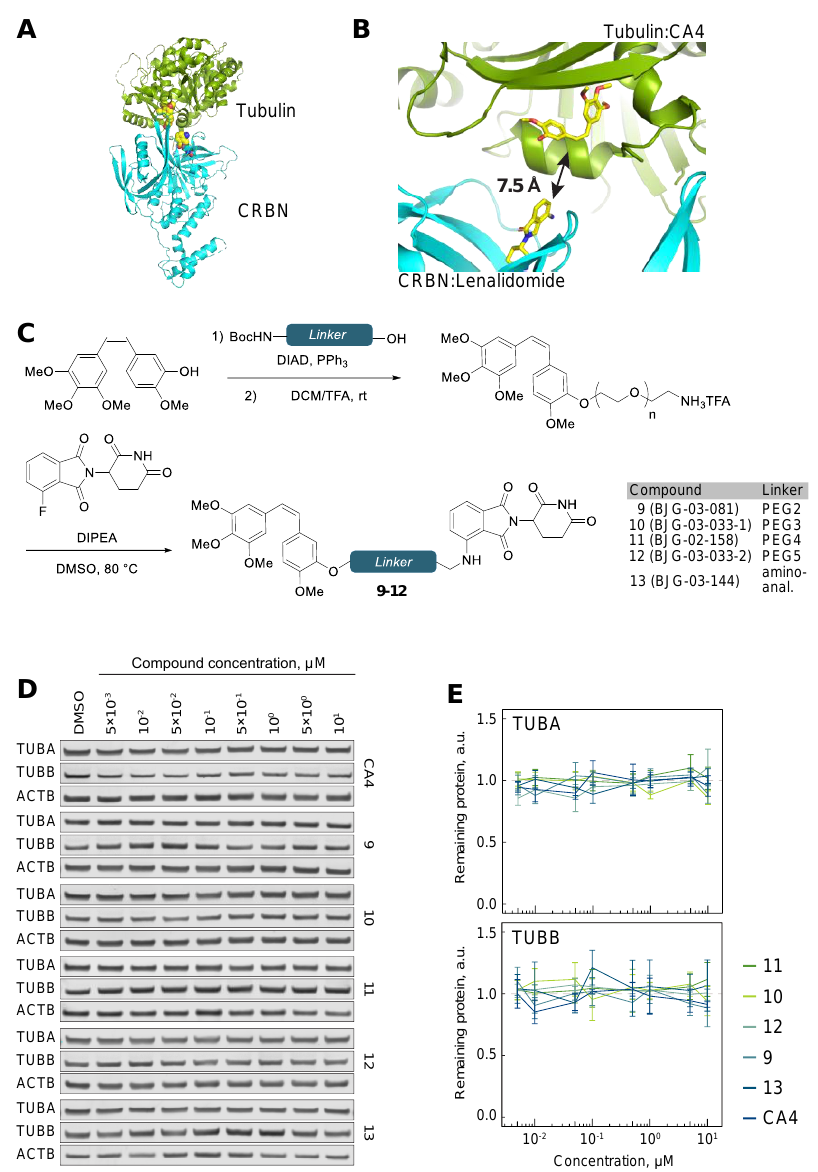
Figure 4. Tubulin evades CA4-CRBN targeted degradation. ( A ) The shortest linker docking pose of CRBN-bound lenalidomide (PDB ID 5fqd) and tubulin-bound CA4 (PDB ID 5lyj). ( B ) Corresponding shortest pairwise distance between lenalidomide and CA4 is permissive of a degrader approach. ( C ) Chemical synthesis of CA4-CRBN a degrader compounds with varying linkers. ( D ) TUBA and TUBB protein levels in hTert-RPE1 cells upon treatment with the indicated compounds. ( E ) Quantification of tubulin protein levels across the indicated conditions. All data are normalized to ACTB, then to tubulin protein levels in DMSO-treated cells. Lines represent average of three biological replicates. Error bars represent SEM.